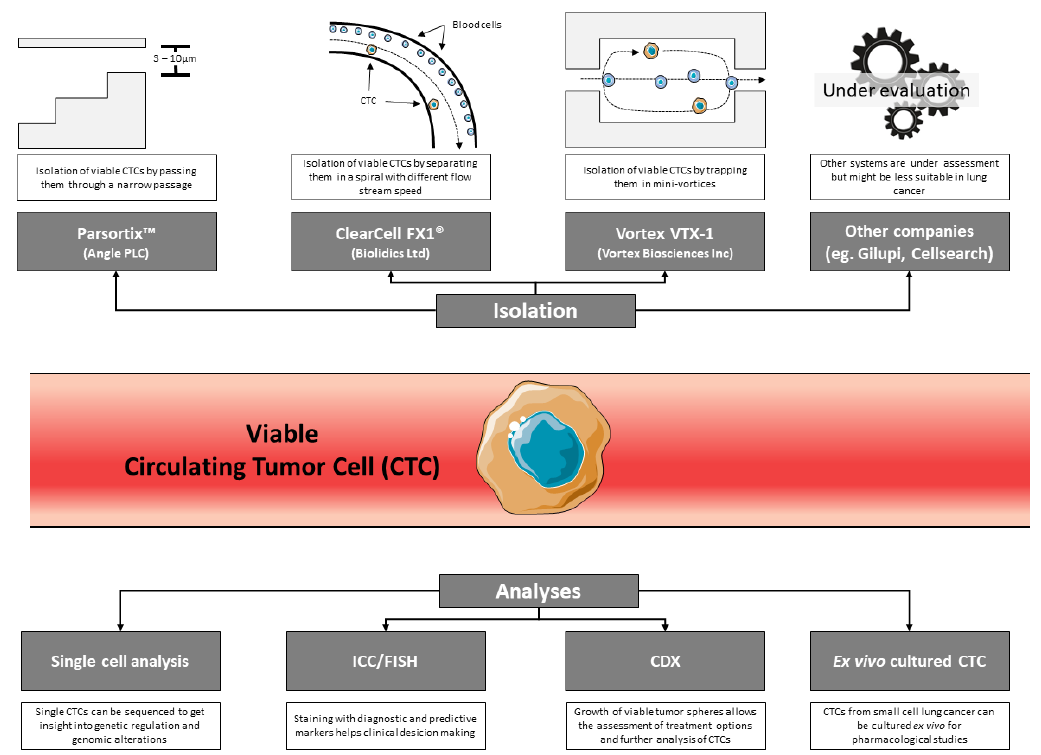
Figure 1. Overview of the different isolation techniques and possibilities in CTC research. Different devices have been developed with Parsortix (Angle PLC, Guildford, UK), ClearCell FX1 (Biolidics, Singapore), and Vortex VTX-1 (Vortex Biosciences, Pleasanton, CA, USA) being the most prominent. However, other CTC isolation systems, like GILUPI (Potsdam, Germany), can also be used for